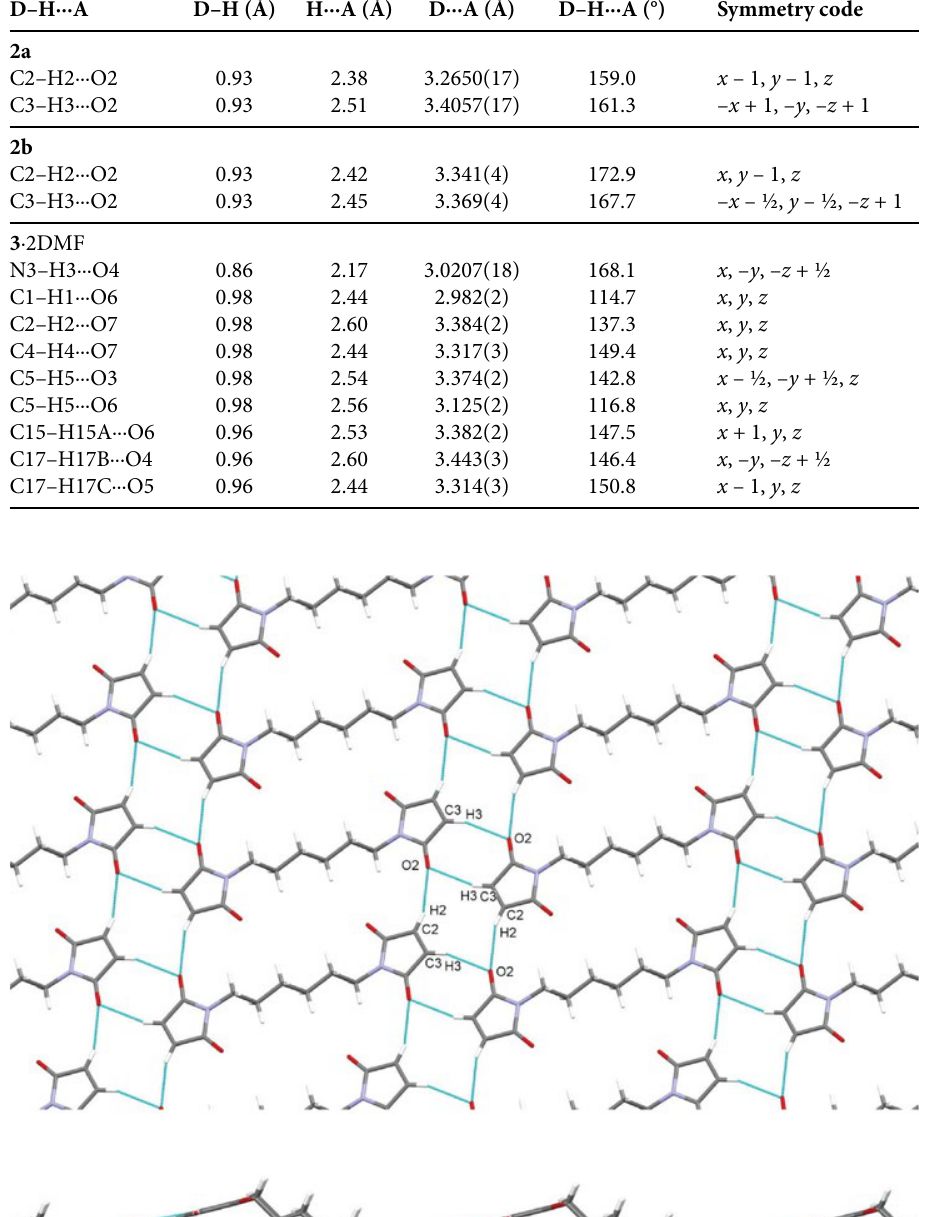
Figure 2. 2D layer formation in 2a generated by C–H···O hydrogen bonding (blue dashed lines) with graph set motifs R 2 along the layer